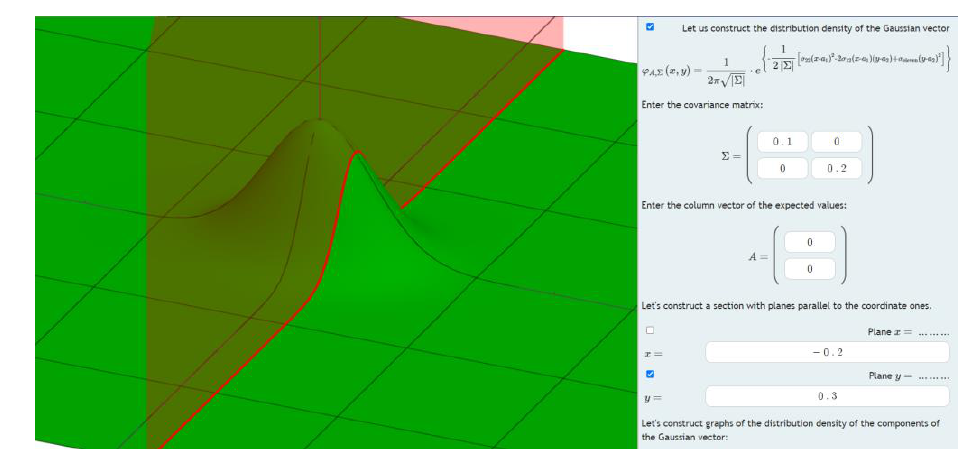
Fig. 3. Working with two-dimensional Gaussian density in DLS Nomotex.